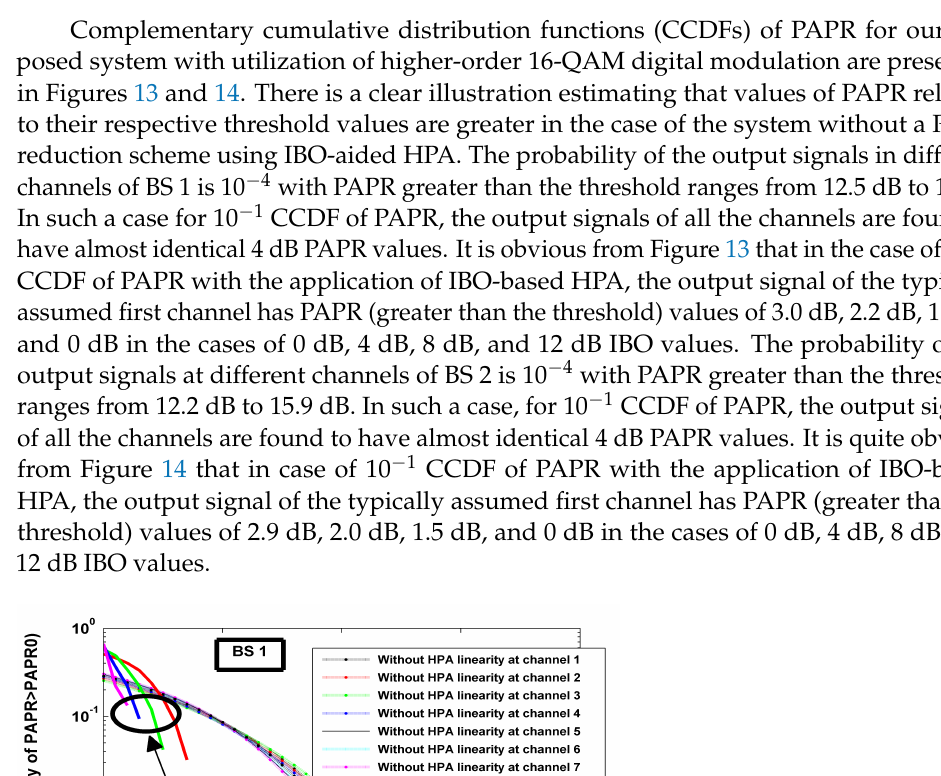
Figure 12. Estimated ergodic achievable rate versus transmitted power in presence of CoMP − JT − based mmWave signal transmission.